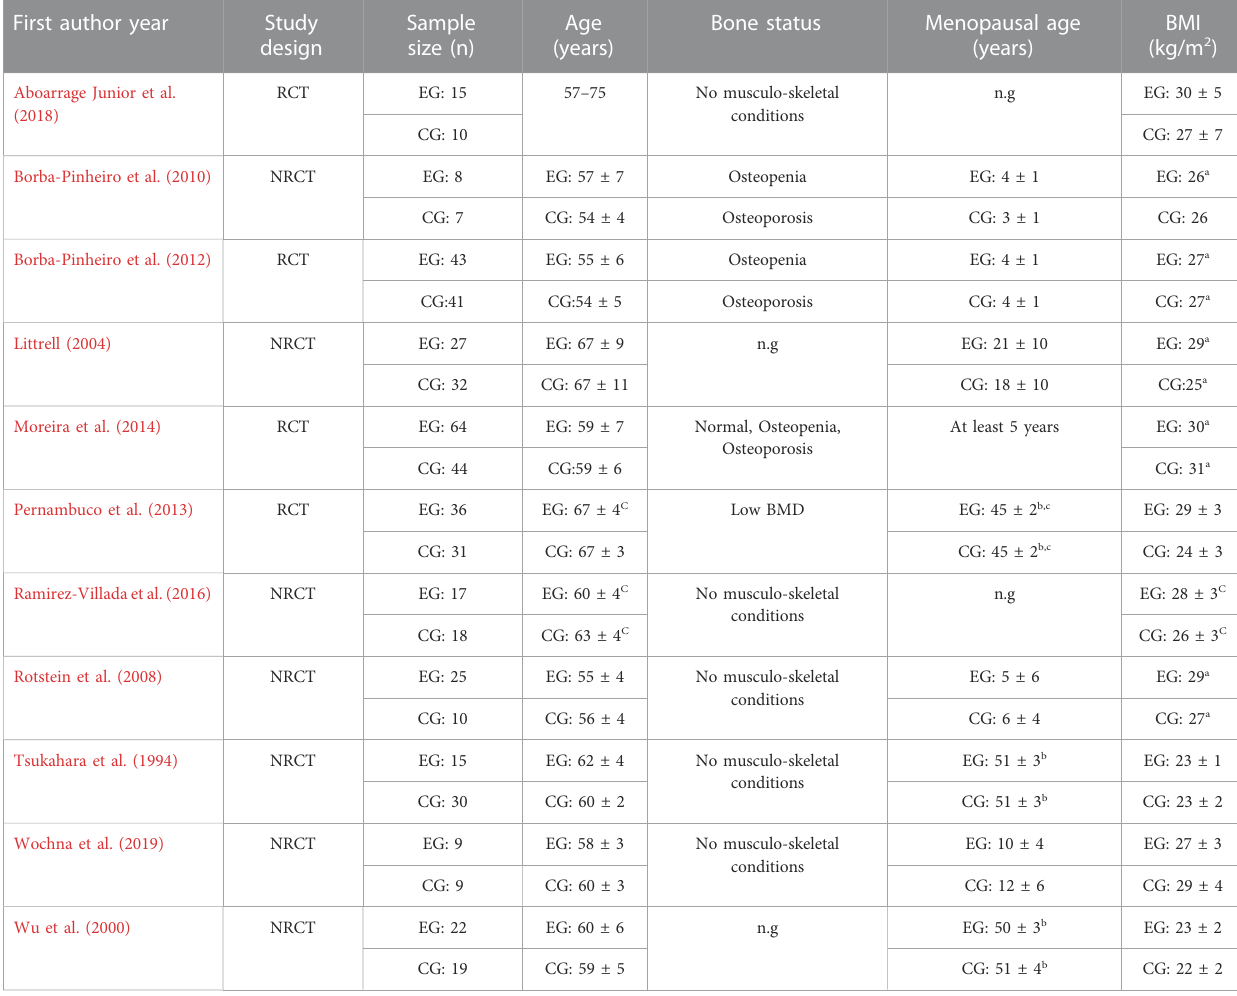
TABLE 1 Study and participant characteristics of the included